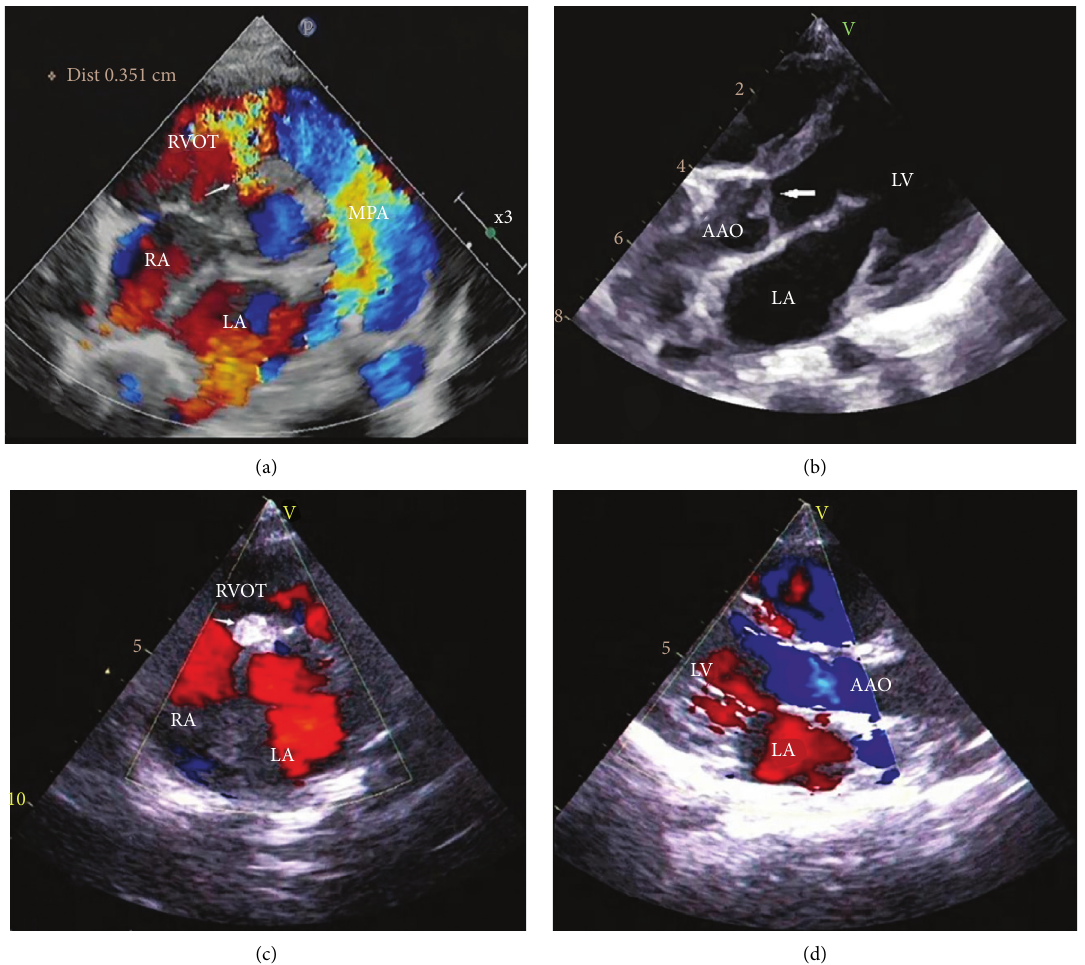
Figure 2: (a) Transthoracic echocardiography (TTE) showing the location of perimembranous ventricular septal defect and color Doppler image demonstrating a left to right jet through the defect (white arrows). (b) Moderate AVP is evident (white arrows). (c) TTE dem- onstrating optimal occluder position and absence of residual shunt after release of the occluder (white arrows). (d) After successfully implanting VSD occluder, parasternal long-axis TTE confirms no AR (LA � left atrium; RA � right atrium; RVOT � right ventricular outflow tract; MPA � main pulmonary artery; LV � left ventricle; AVP � aortic valve prolapse; AR � aortic regurgitation; VSD � ventricular septal defect; AAO � ascending